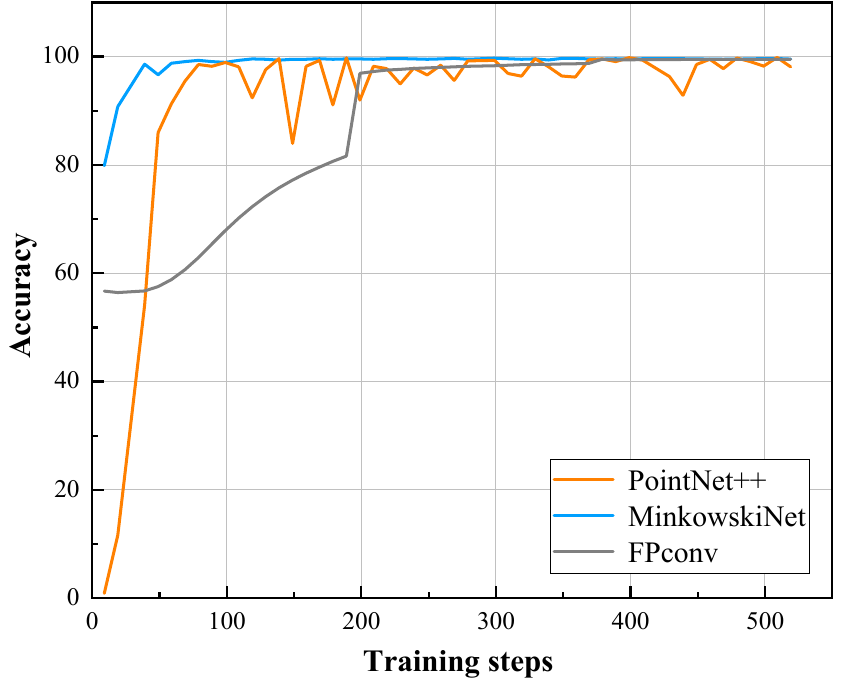
Figure 11. Visualization of the training process. The qualitative results of the three segmentation models are shown in Figure 12. Each point represents a classified component (tree or ground). The segmentation accuracy of the PointNet++ model is relatively low. There were points of the ground incorrectly segmented as points of the trees, and most of the incorrectly segmented points were concentrated on the left side of the figure. There were missed segmentations of points of each tree; therefore, its segmentation accuracy of trees was low. The segmentation accuracy of both the trees and the ground in the MinkowskiNet model was very high, only some points of individual trees were incorrectly segmented as points of the ground. The ground segmentation accuracy of the FPConv model was relatively high, and each tree had points that were wrongly divided into ground points. Therefore, it can be concluded that the MinkowskiNet model has the best effects for the point segmentation of the trees and the